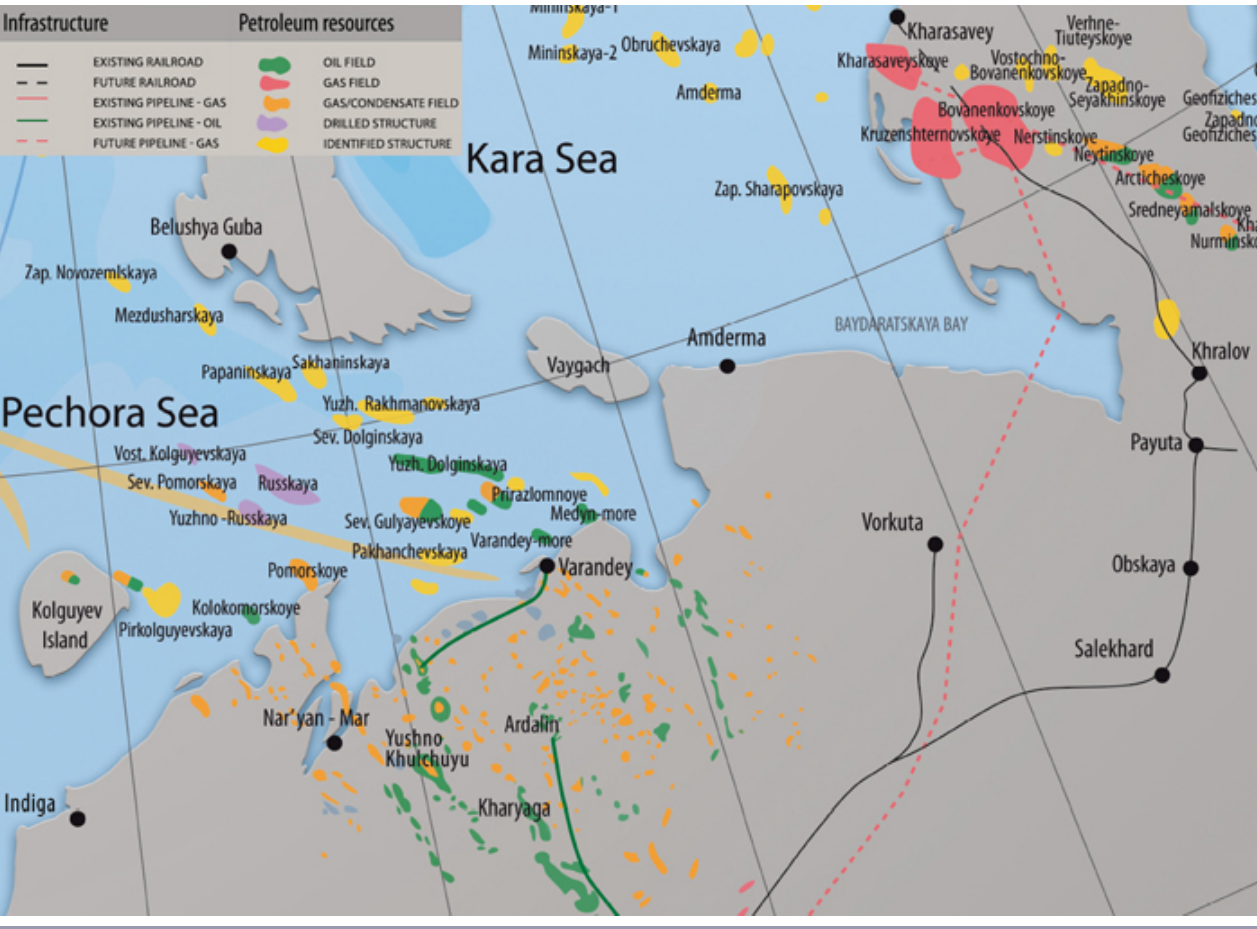
Fig. 1 . Hydrocarbon resources of Arctic Europe and West Siberia. Permission to use granted by Sherpa Konsult as, Oslo,